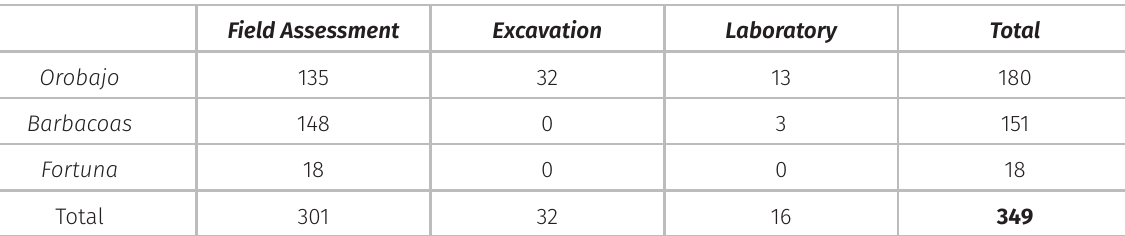
Table V. Data of the skeletons located in each phase. Field